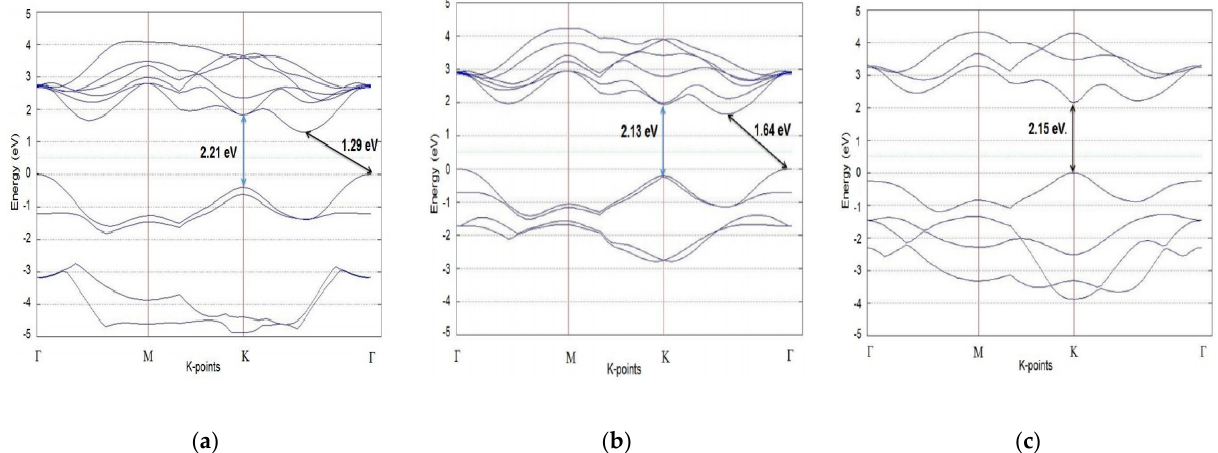
Figure 3. Band structure and possible transitions of ( a ) bulk WS 2 ; ( b ) bilayer WS 2 ; ( c ) monolayer WS 2 . Reproduced with permission. [37] Copyright 2018, Wiley VCH.